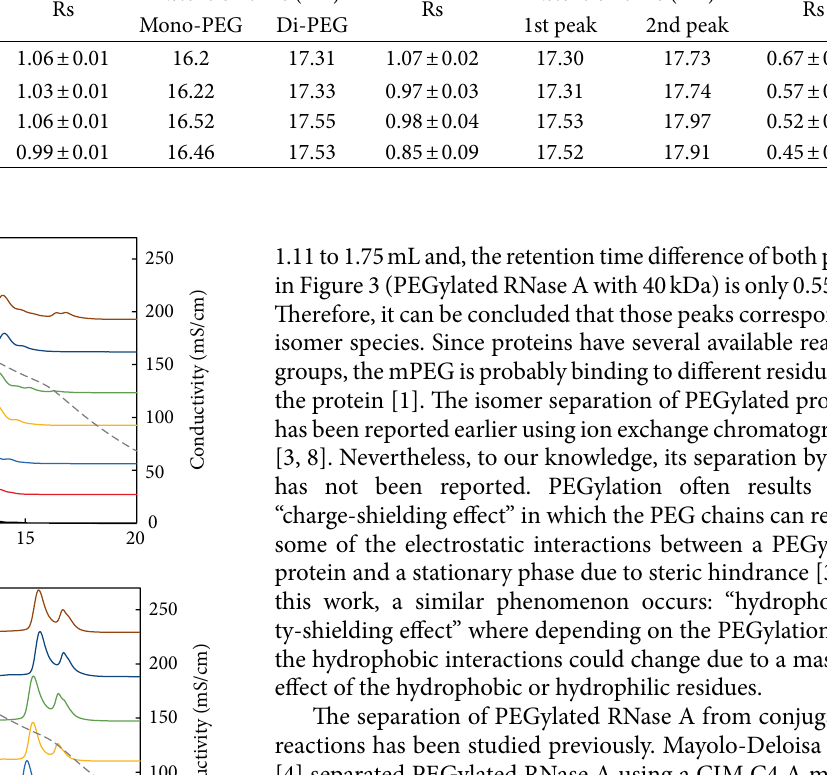
Table 3: Retention time and resolution factor (Rs) of PEGylated Ribonuclease A using combined PEGylated monoliths in series. PEGylated monoliths